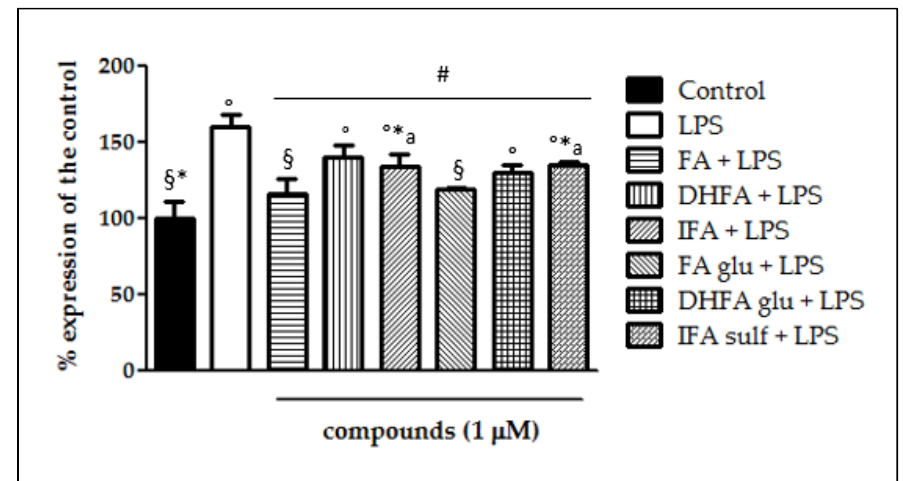
Figure 3. Expression of iNOS dosed by qRT-PCR and reported as a percentage of the control, in Caco-2 cells treated with LPS (1 µ g/mL) for 48 h and pretreated for 30 min with with FA, DHFA, IFA, FA glu, DHFA glu, and IFA sulf (1 µ M) prior to LPS co-exposure. Control and LPS groups were pretreated with an equivalent volume of methanol. Each column represents the mean ± SD of independent experiments ( n = 6). Significant differences among groups are described using different superscript symbols; # = significant vs. LPS ( p < 0.001); ◦ = significant vs. control ( p < 0.001); * = significant vs. FA glu + LPS ( p < 0.05); § = significant vs. DHFA + LPS ( p < 0.001); a = significant vs. FA ( p <